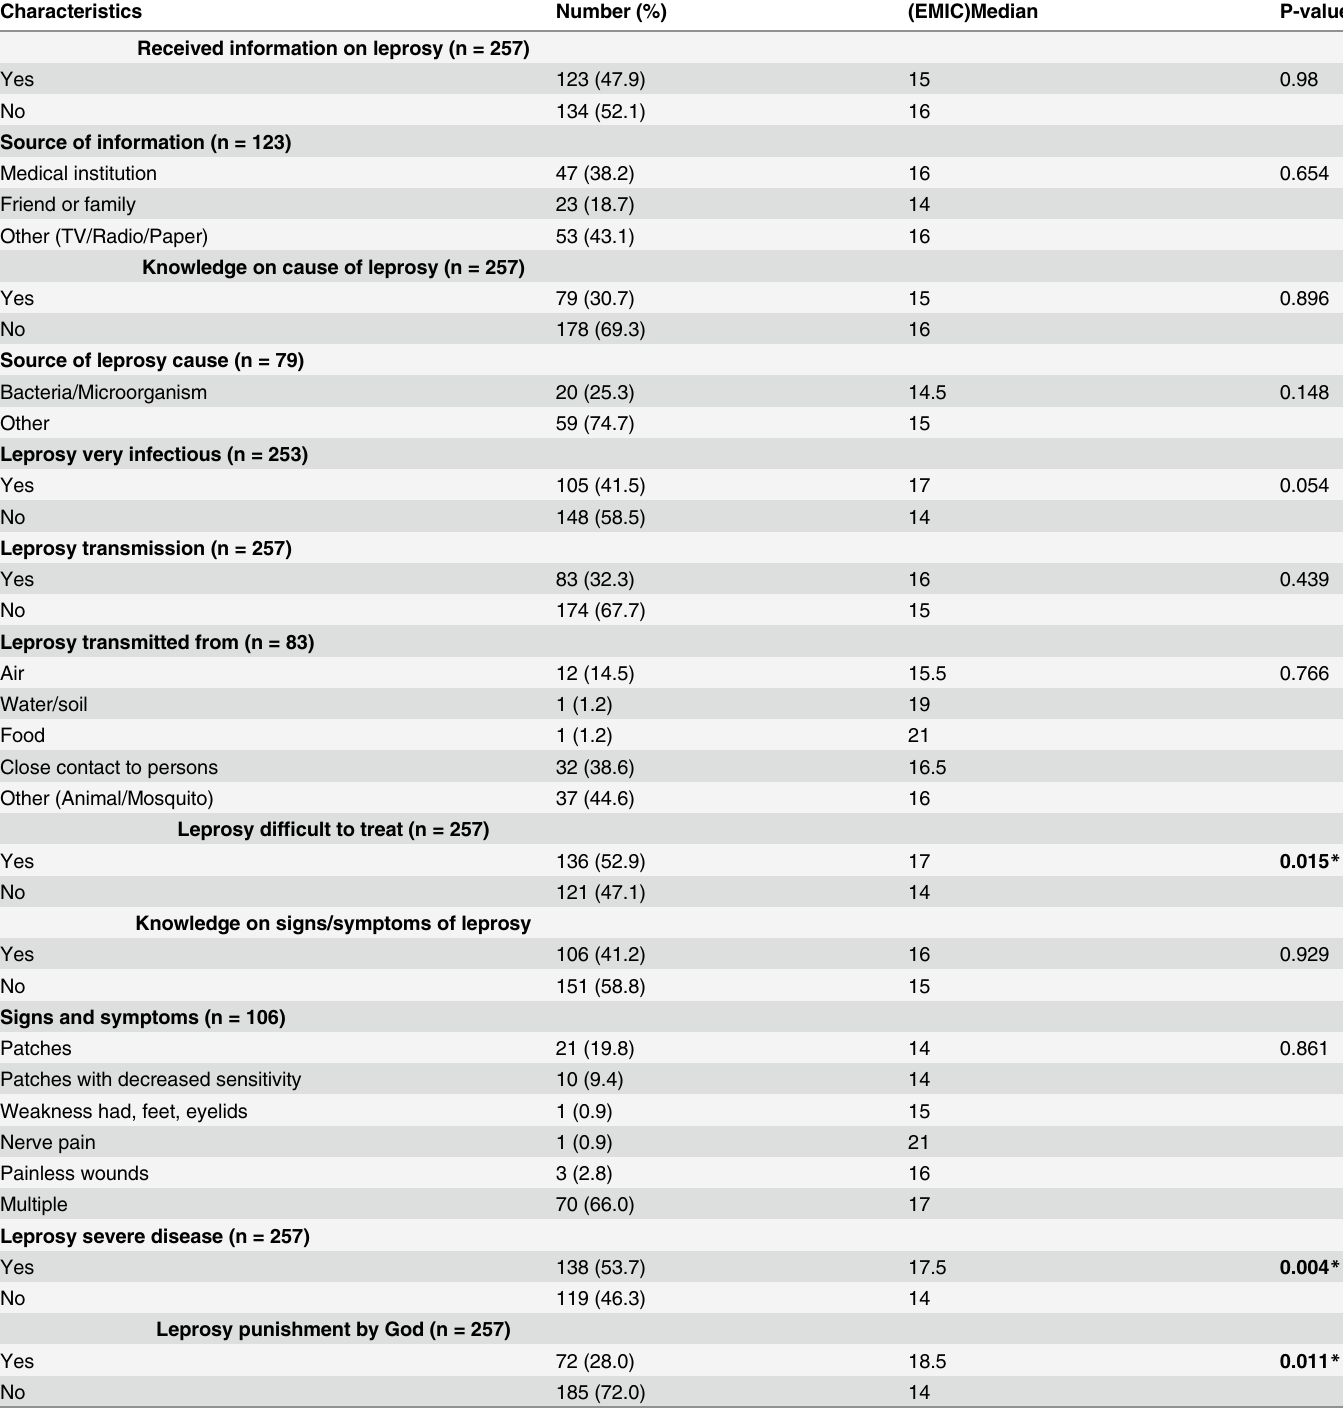
Table 2. Knowledge on leprosy of the participants and EMIC score (n =